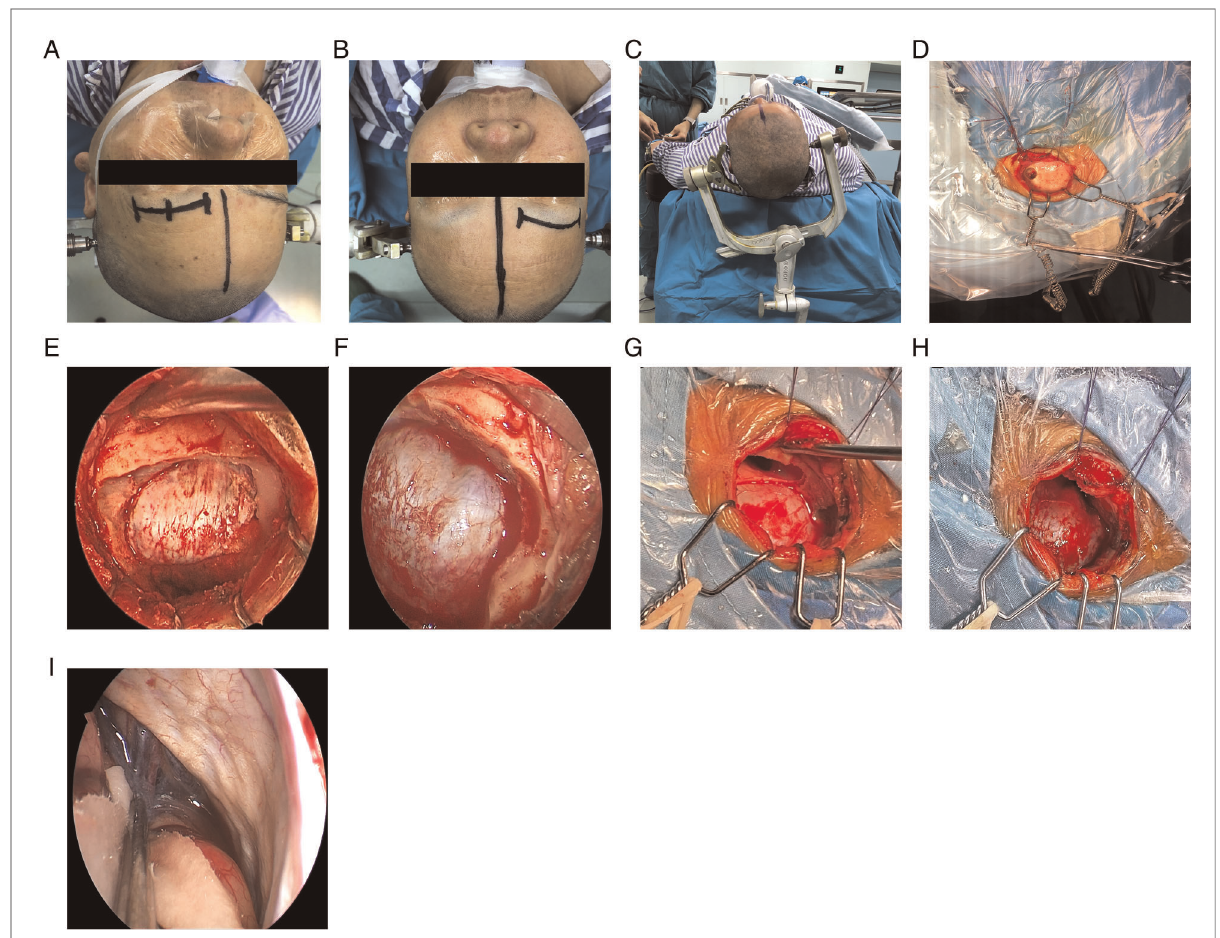
FIGURE 2 Operating procedure. ( A,B ) Location of the surgical approach. ( C ) The DORO head brace was used to fi x the head of the patient. ( D ) Upward retraction using two “ fi shhook-morphous ” retractors. (E) Removal of the small free bone fl ap. ( F ) Supraorbital nerve. ( G,H ) Opening of the frontal sinus: before and after. ( I ) Release of cerebrospinal fl